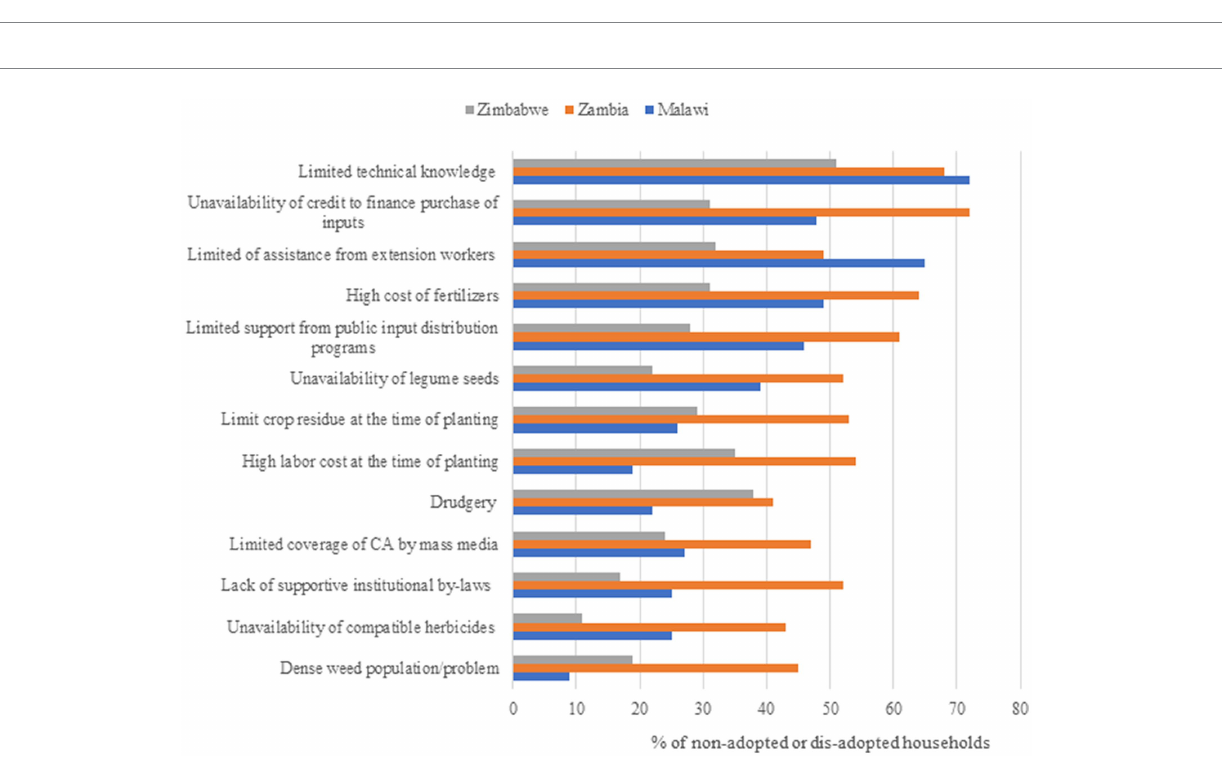
FIGURE 6 Perception of new agricultural technologies by country (% of households).